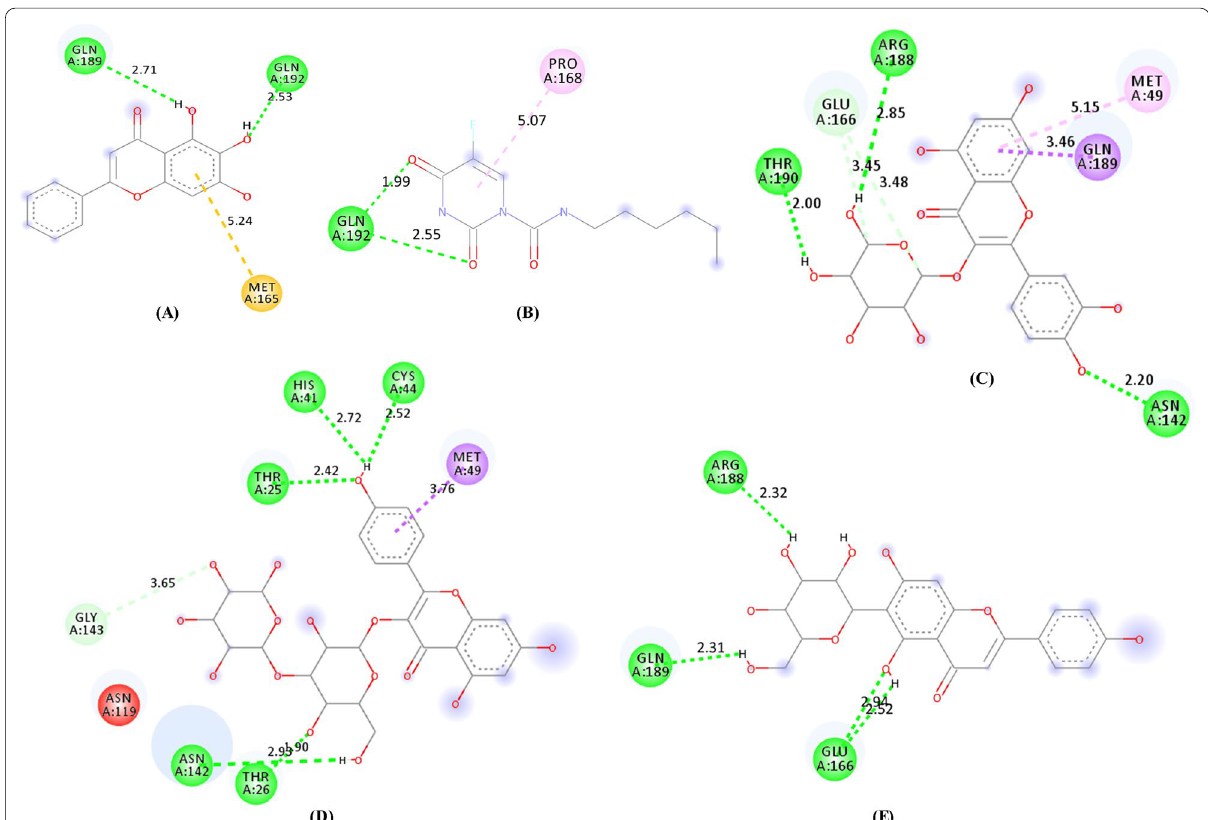
Fig. 4 Visualization of 2-dimensional ligand interactions between the amino acid residues of the active binding pockets of SARS-CoV-2 M pro with ( a ) 3WL, ( b ) carmofur, ( c ) C_18, ( d ) C_4 and ( e )